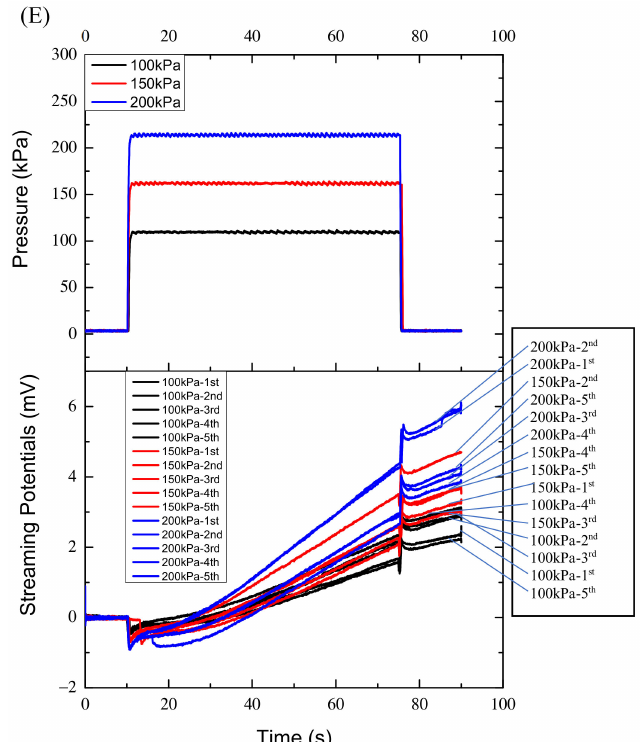
Figure 2. ( A ) Curves of streaming potential of specimen one without pressure. ( B ) Curves of streaming potential versus time for specimen one under the three pressures selected. ( C ) Curves of streaming potential versus time for specimen two under 100 kPa. ( D ) Curves of streaming potential versus time for specimen three under 150 kPa. ( E ) Total fifteen curves of streaming potential versus time for specimen four under 100, 150 and 200